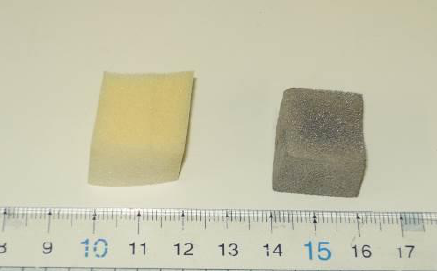
Figure 4. ( Left ) Low-rebound urethane foam block before irradiation with ultrasound; ( Right ) Conductive foam block produced by irradiating the urethane foam block with ultrasound in the reaction